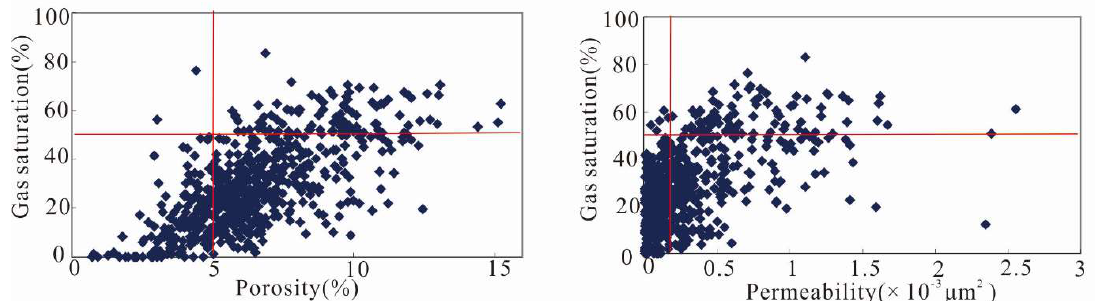
Figure 6. Relationship between porosity, permeability, and gas saturation in Sulige gas field.